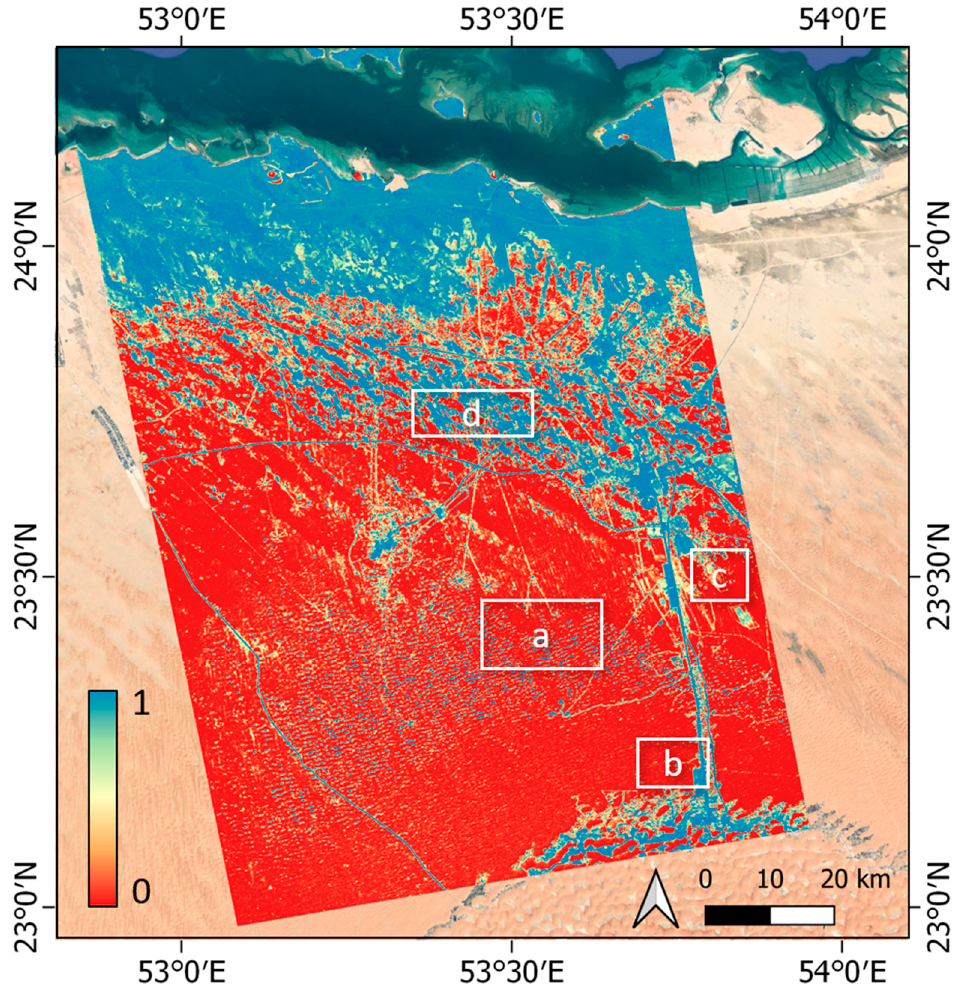
Figure 5. Temporal Stability Index (TSI) map. Very low values of TSI (red color) indicate areas partially or totally unstable. Basemap: © Google 2019 Copyright.